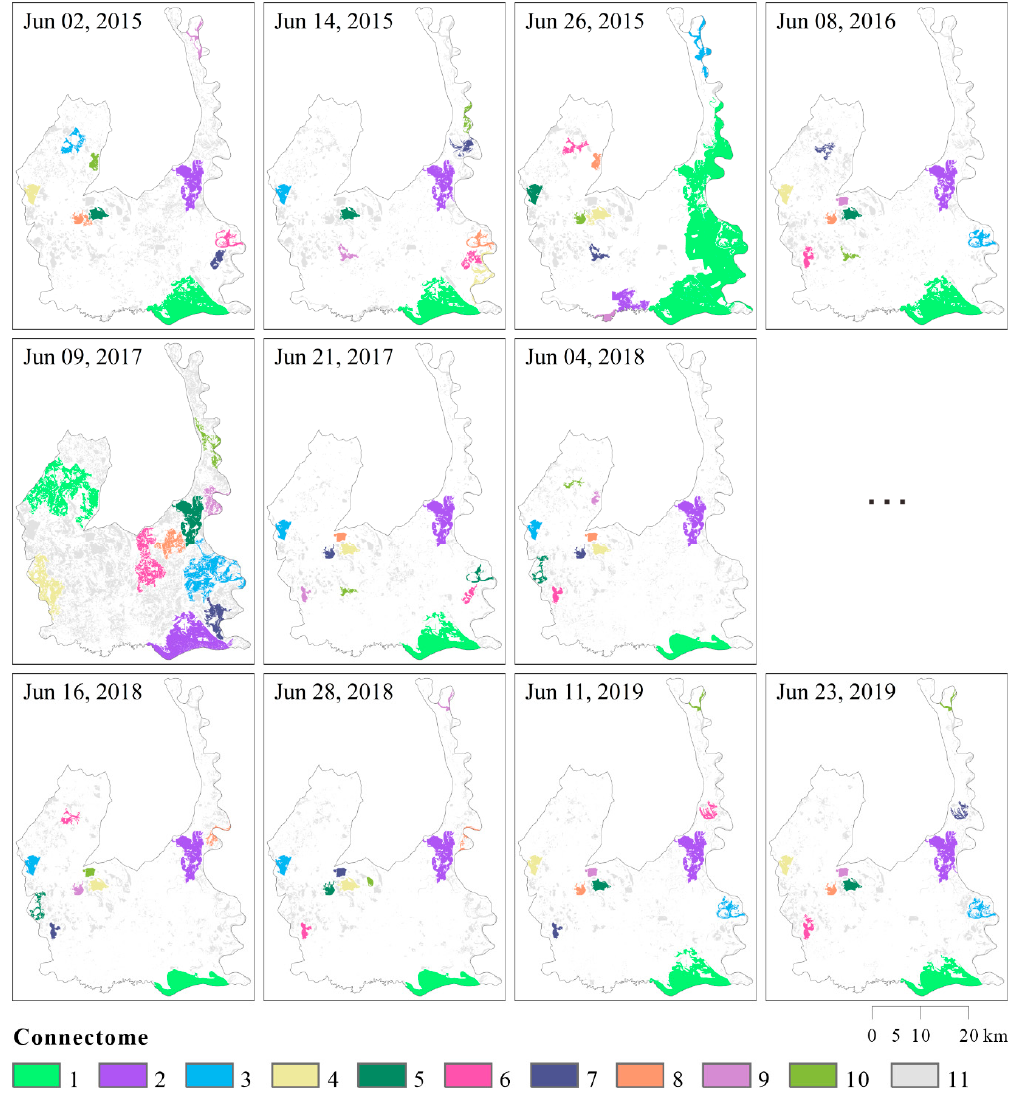
Figure 10. Spatial distribution of the connectomes (i.e., seasonally connected water bodies) in China’s Momoge National Nature Reserve in June. Colors 1 to 10 in the legend refer to the top ten largest connectomes, and color 11 refer to the remaining connectomes and isolated water bodies.